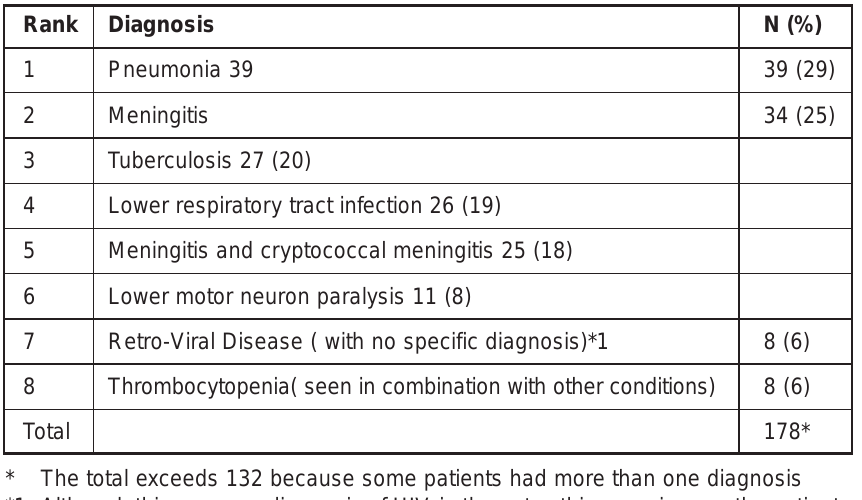
Table 3: Illustration of diagnoses found in patients’ records (N=132).